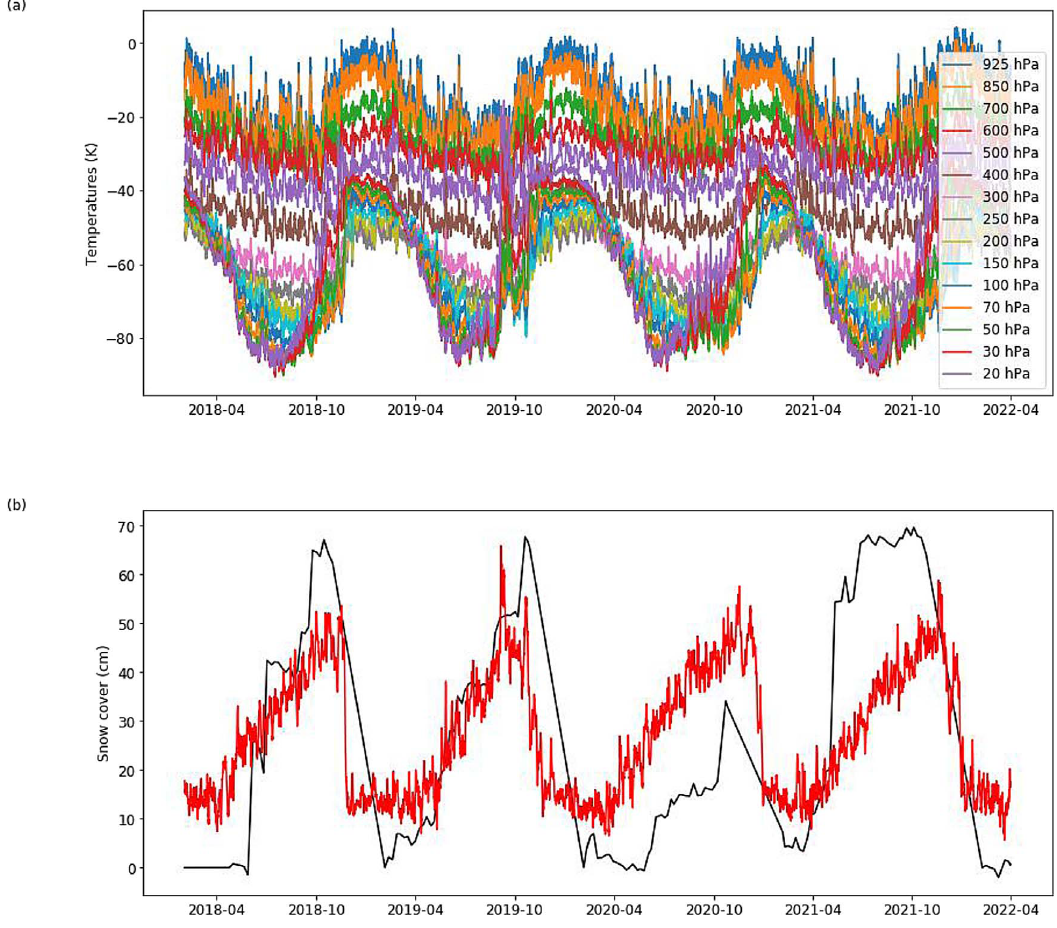
Figure D1. (a) Input vectors of GDAS temperatures at 925, 850, 700, 600, 500, 400, 300, 250, 200, 150, 100, 70, 50, 30, and 20 hPa and (b) output vector of the snow cover depth with the ESN result (red). Black curve is the observed snow cover in Figure